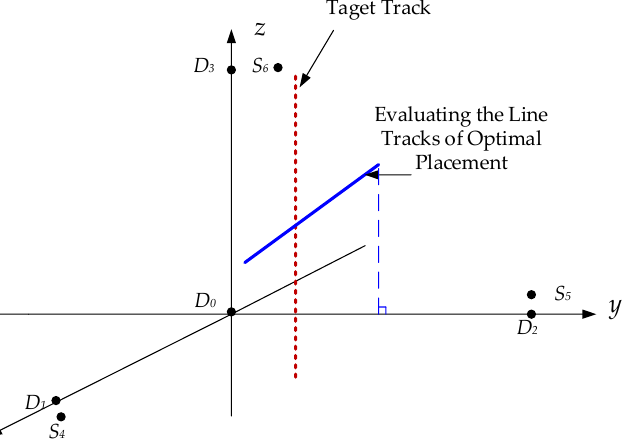
Figure 3. Schematic Diagram of Receiving Station Placement and Target Line Trajectory for TOA/TDOA hybrid source localization system.